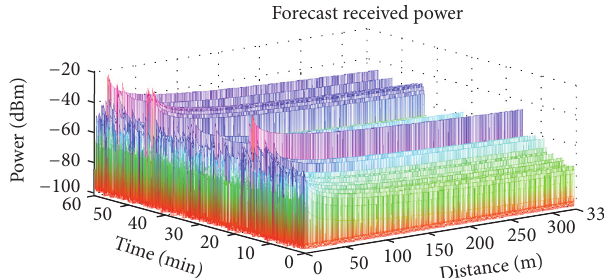
Figure 11: Forecast received power for the proposed model.